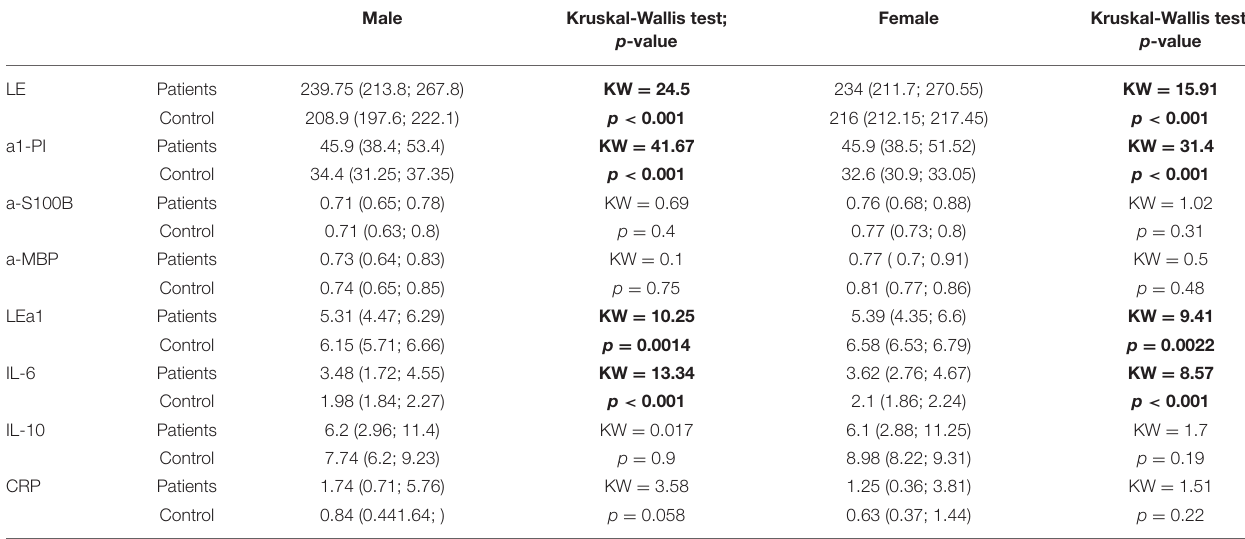
TABLE 3 | Descriptive statistics of neuroinflammatory biomarkers in the group of patients and healthy control.